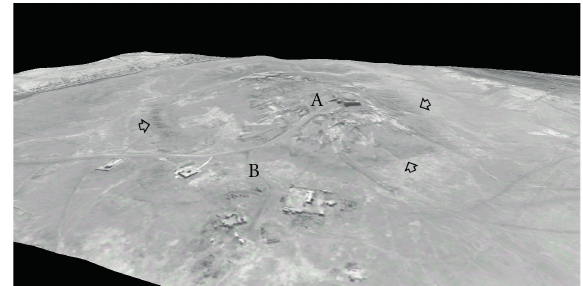
Figure 7: The QuickBird-2 panchromatic image of April 2004 draped on the DEM based on SRTM data: a view from the north, with the Ziggurat on the top of the hill (A), and the North Harbour area (B); the arrows indicate traces and remains of the city